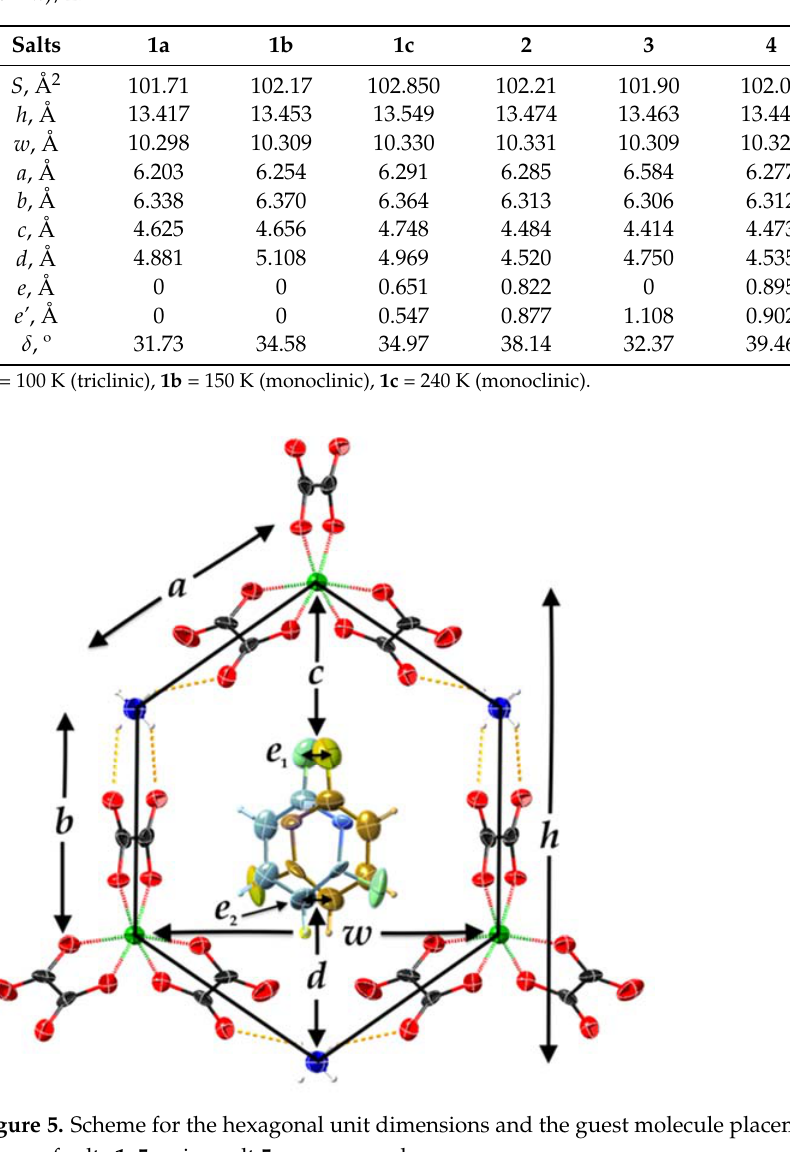
Table 4. The dimensions of the anion layer hexagonal cavity and the orientation of the HalPy guest molecule as annotated in Figure 5. δ is the angle between the pyridine ring plane and the plane of the hexagonal cavity. e is a mean guest molecule displacement defined as ( e 1 + e 2 )/2, where e 1 is a displacement of the outer halopyridine halogen atom nearest to the cusp Fe 3+ ion around the twofold axis, e 2 is a displacement of the inner halopyridine ring carbon/nitrogen atom closest to the nadir nitrogen atom of NH 4+ ion. e’ is an alternative mean displacement value ( e 1 + e 2 + . . . + e n )/ n where averaging is taken for all displaced atoms. S is a square unit of the hexagonal cavity taken as w ( b + h )/2.